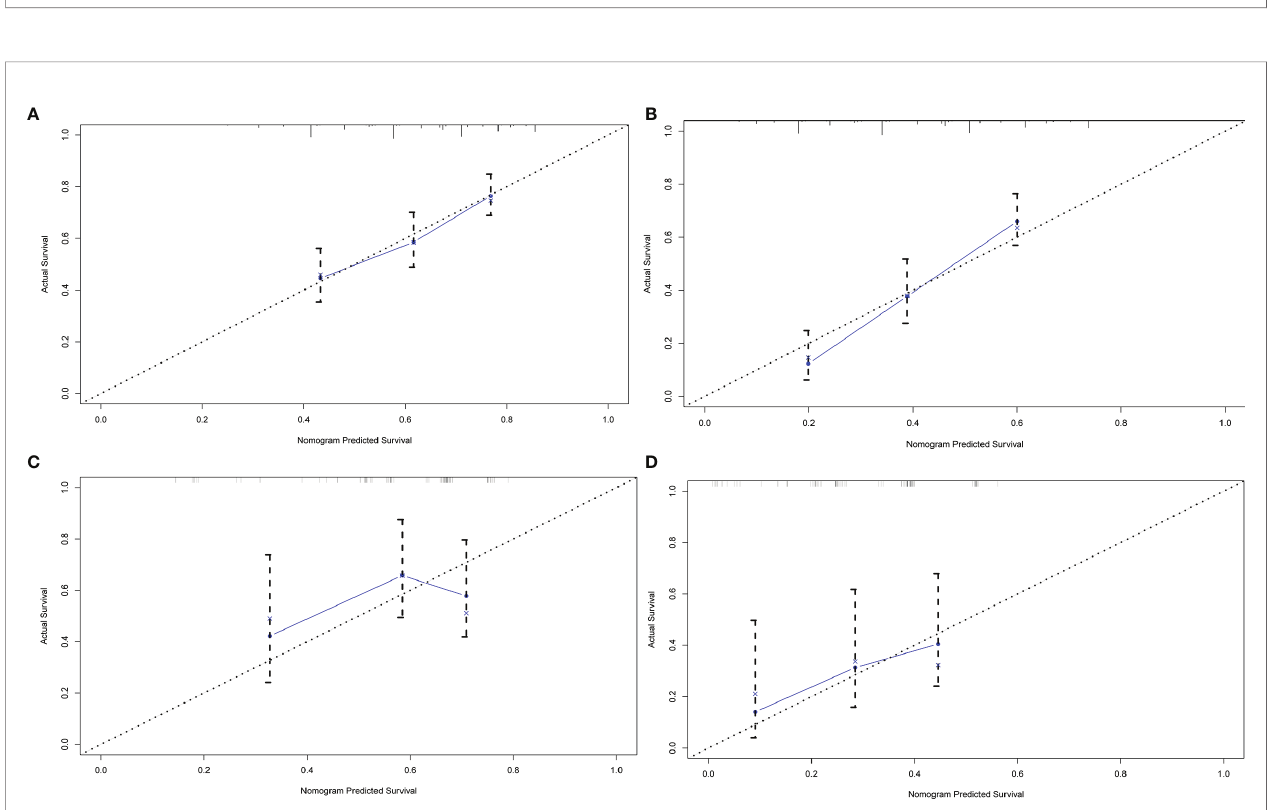
FIGURE 2 | Nomogram to predict 3- and 5-year OS rates of lnNPC patients. rT, T stage after recurrence; NLR, neutrophil to lymphocyte ratio; SII, systematic immune-in fl ammation index; ALB, albumin.